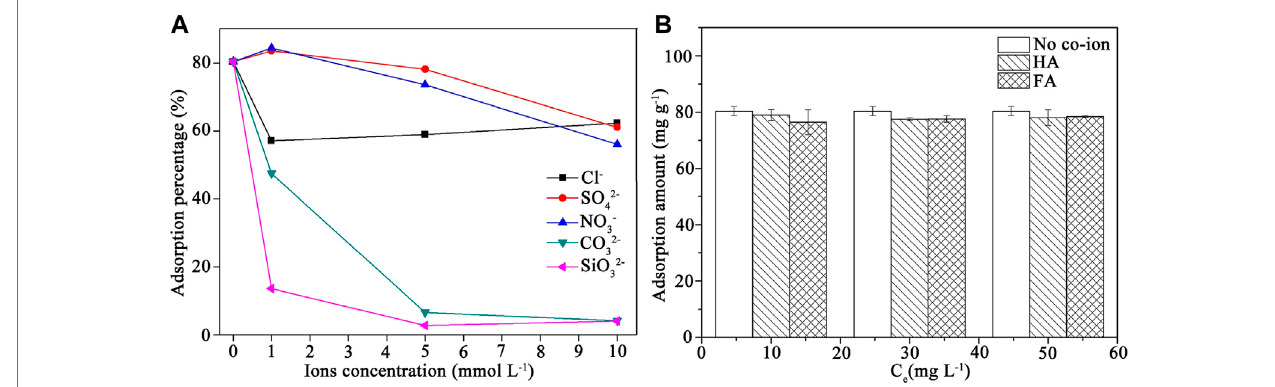
FIGURE 7 | Effects of Cl − , SO 42 − , NO 3 − , CO 32 − , and SiO 32 − (A) and natural organic matter (B) on adsorption of PO 43 − on La 2 (CO 3 ) 3 .